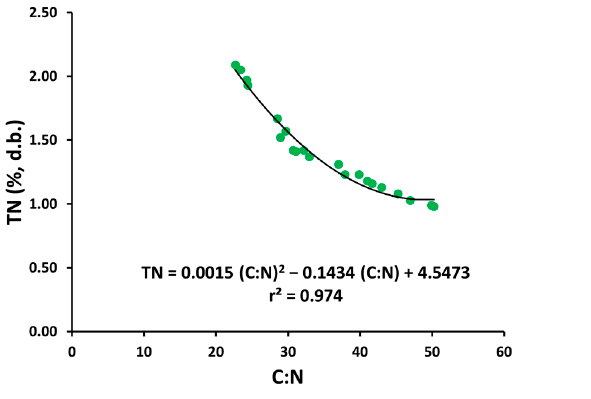
Table 5. Least squared best fit results for plant nutrients with significant correlation with respect to C:N (r 2 = coefficient of determination).